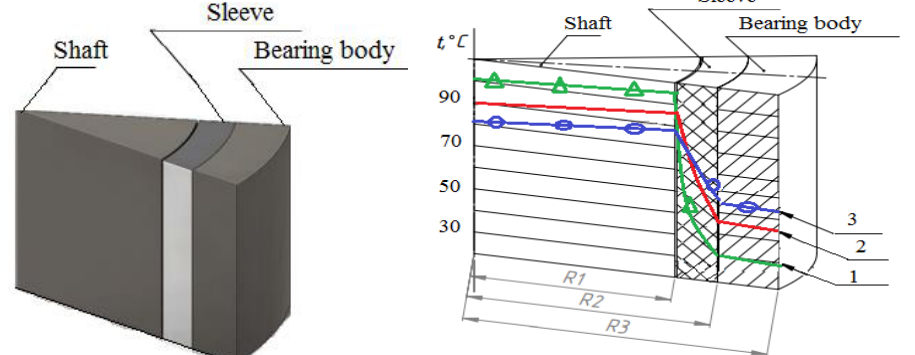
Fig. 2. Temperature distribution in the polymer sleeve bearing (S = 4 mm): 1 - pure polyamide (Ertalon 4.6); 2, 3 - polyamide filled with metal chips (steel 21864) in concentration of 10 and 20% respectively under the action of magnetic field